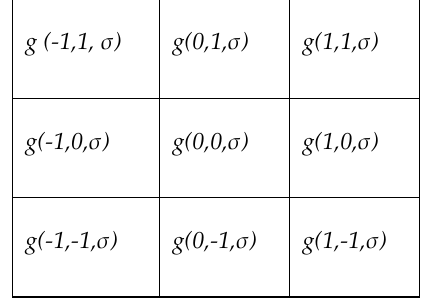
Figure 5. A 3 × 3 filtering kernel of a Gaussian smoothing algorithm.